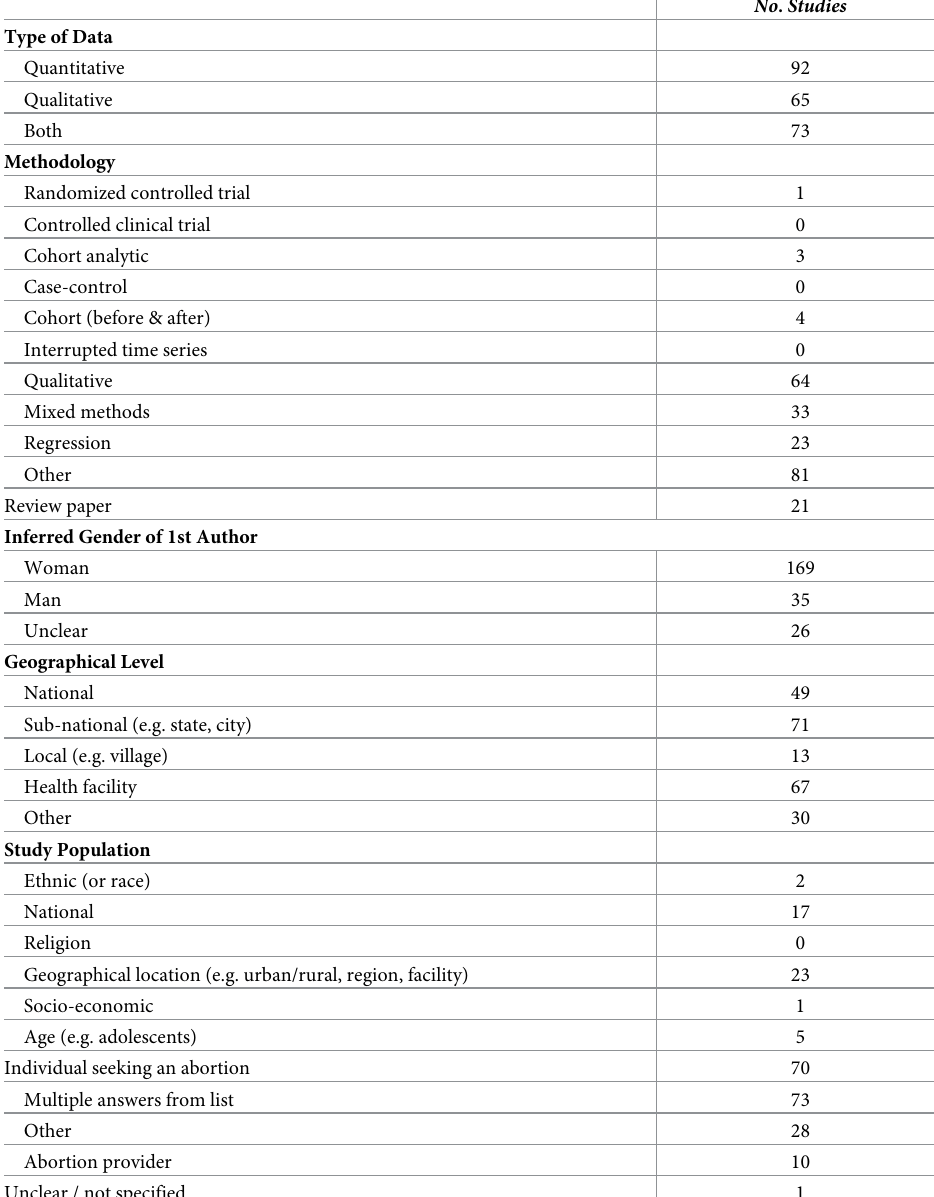
Table 4. Characteristics of included studies [n =